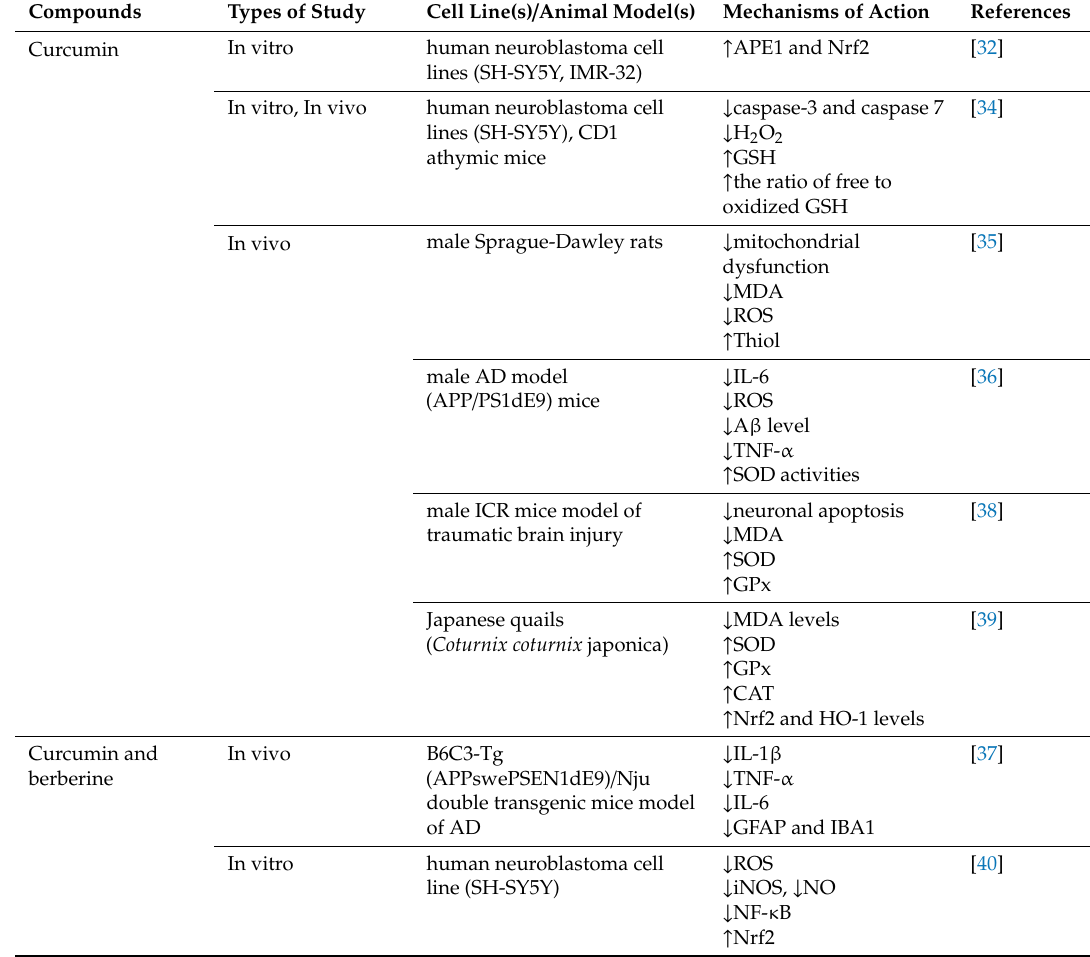
Table 1. Polyphenols in combating AD through Nrf2 / Keap1 / ARE and interconnected pathways.